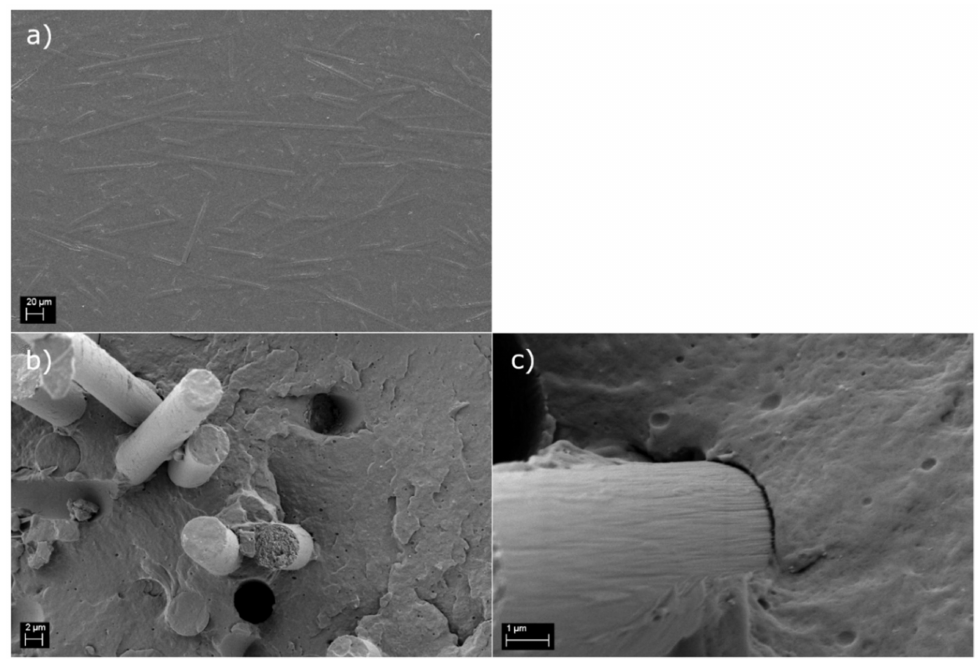
Figure 6. Polished cross-section ( a ) and fracture surface ( b , c ) of the PA6 rCFs compound.